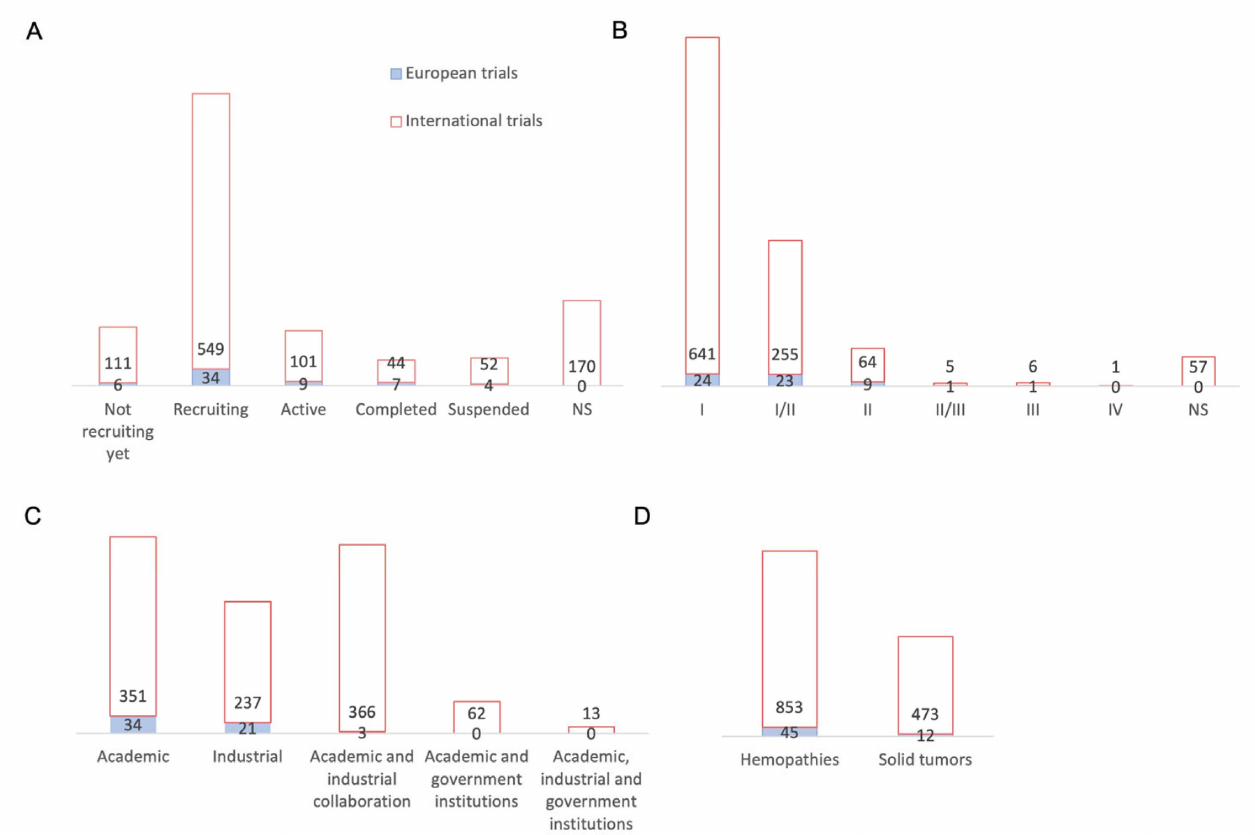
Figure 3. Comparison of European CAR-T cell clinical trials compared with international